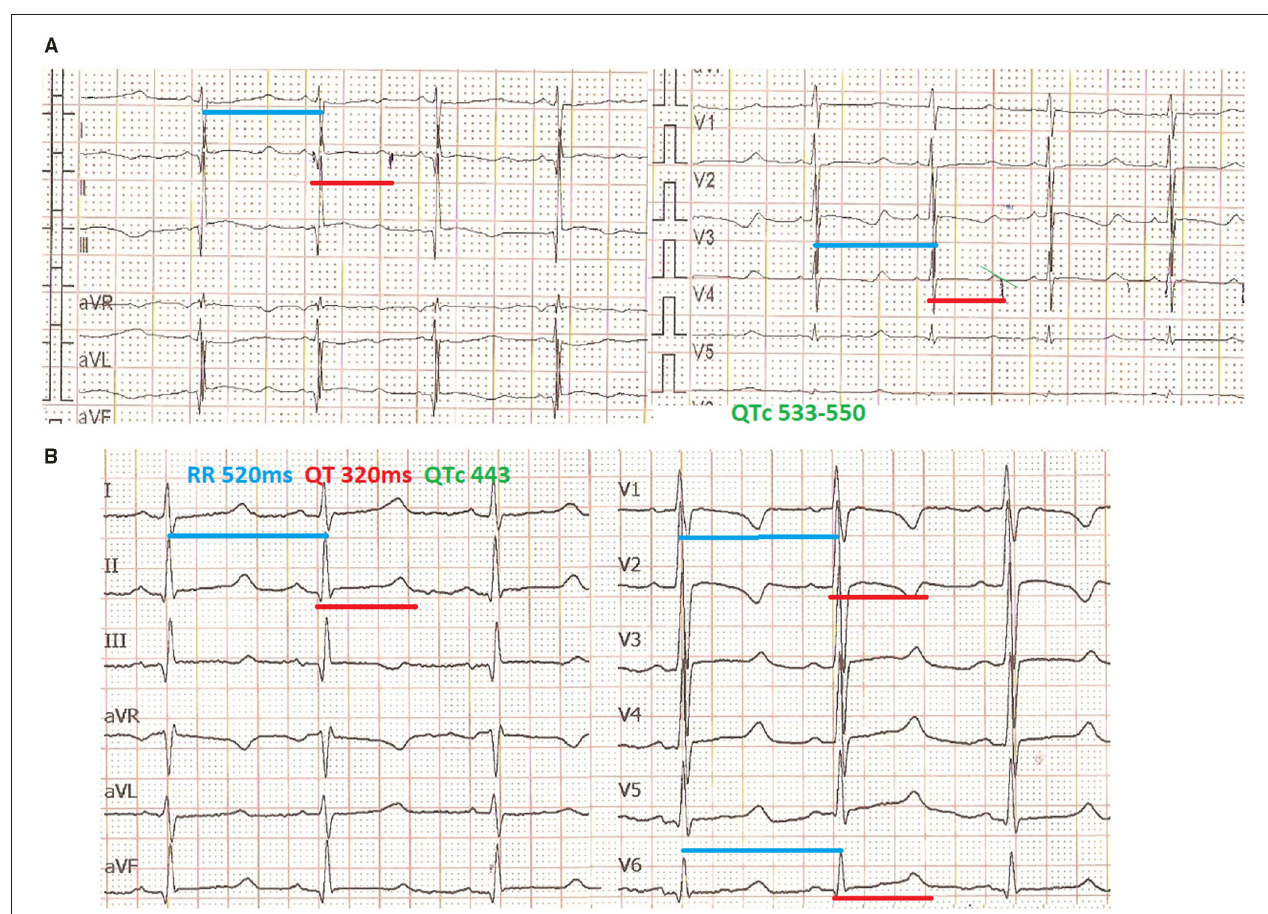
FIGURE 1 | Mexiletine QTc shortening effect. ECG in the first day of life with QTc > 530ms (recording speed 25 mm/s) (A) , ECG at age of 3 months, under mexiletine and propranolol treatment with QTc < 450ms (recording speed 50 mm/s) (B)